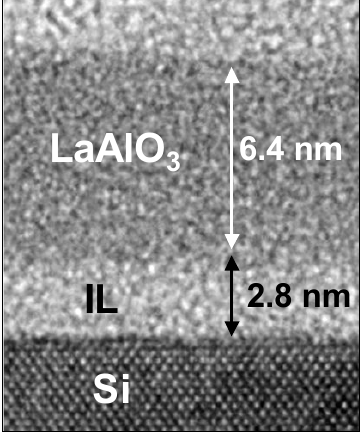
Figure 16. Cross-sectional TEM image of the specimen annealed in an oxygen ambient.